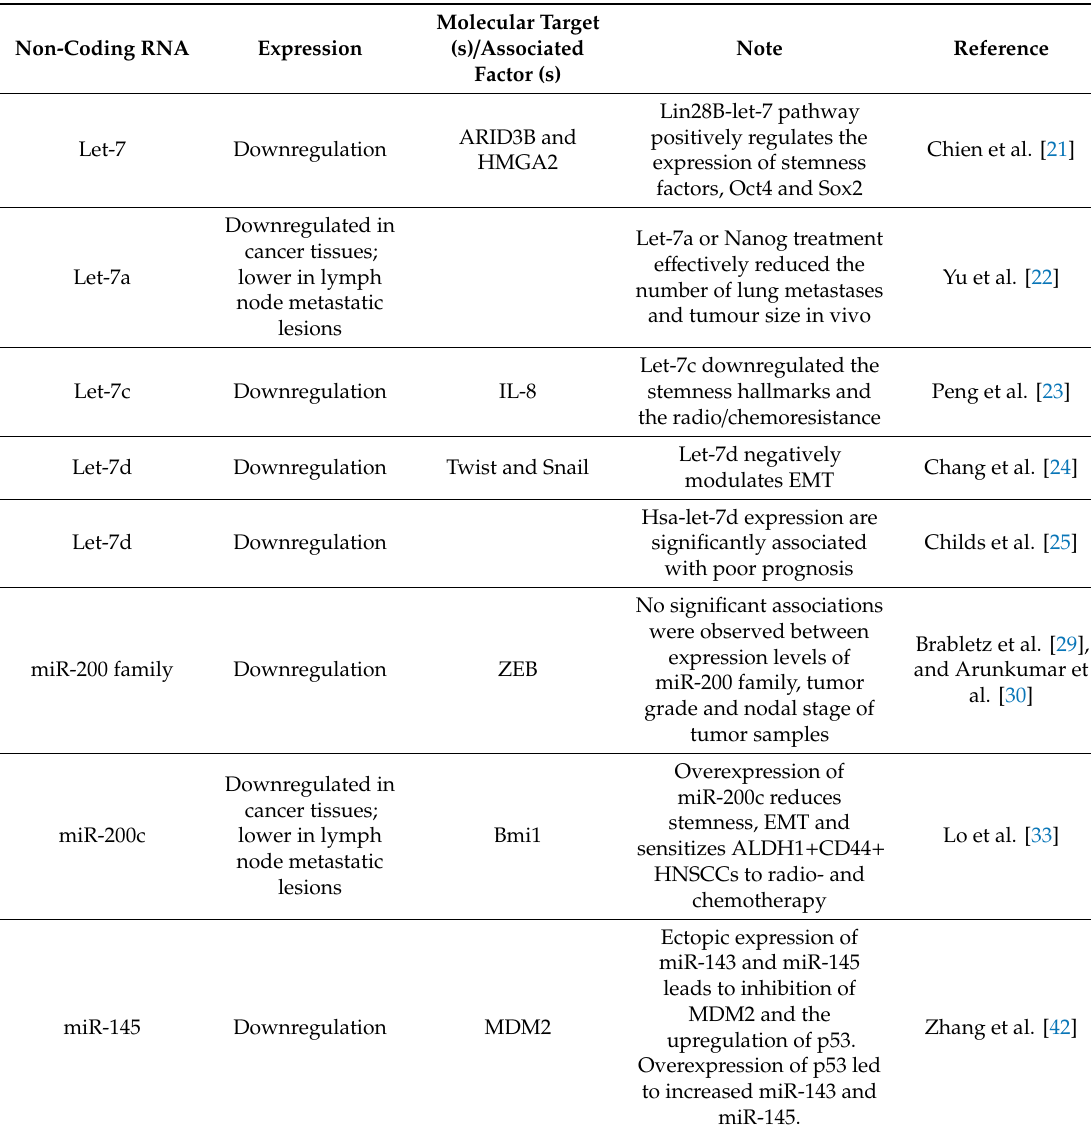
Table 1. The expression of non-coding RNAs in oral squamous cell carcinoma (OSCC) tissues, OSCC cell lines or cancer stem